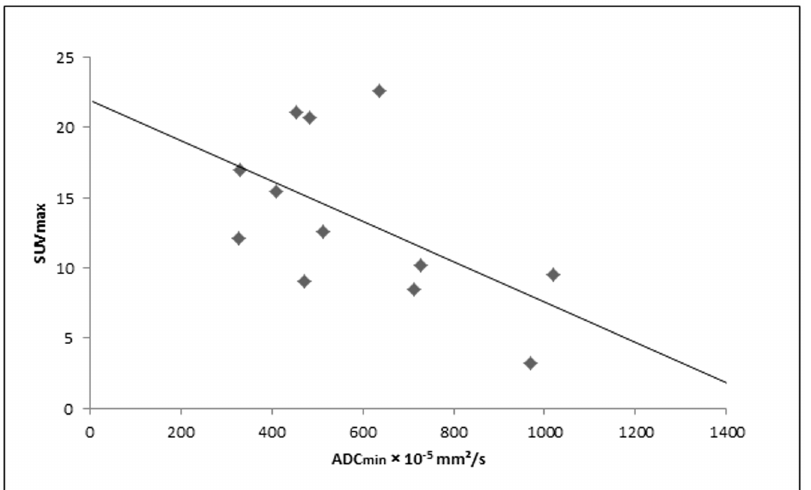
Figure 3. Scatter plot showing a significant inverse correlation between the ADC min and the SUV max for primary and recurrent cervical cancer lesions. (n=12; R= 2 0.628; p , 0.05).